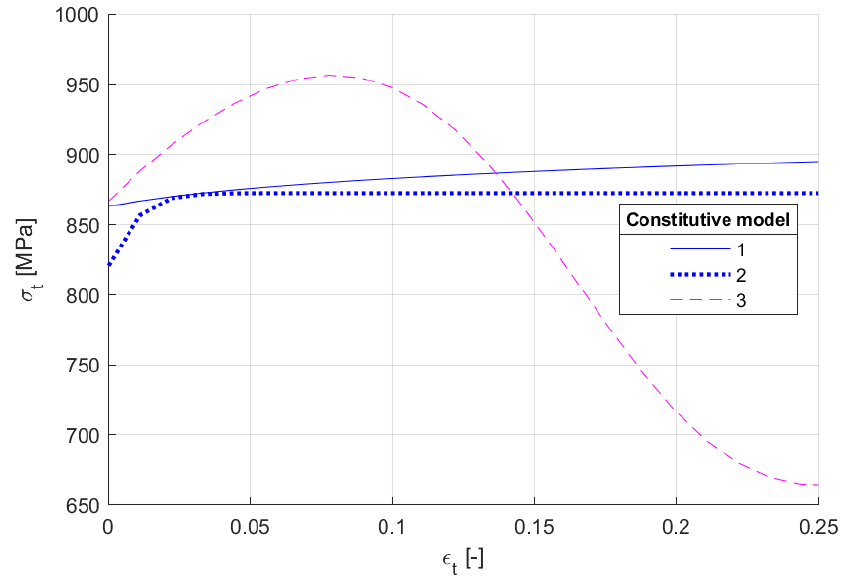
Figure 5. Constitutive model properties initialization using ASTM E646 and MATLAB CFT.